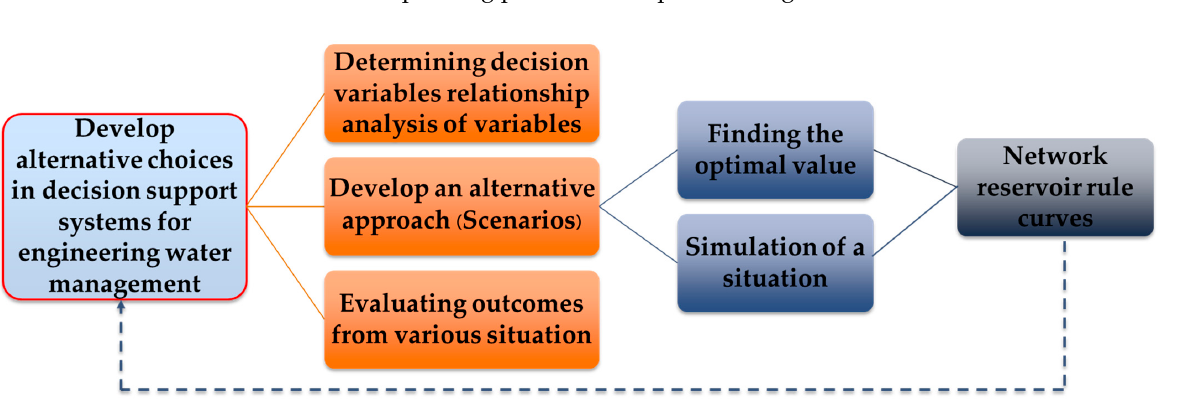
Figure 3. Historical inflow and average downstream water requirements of the Bhumibol and Sirikit reservoirs. 2.2. Establishing a Decision Support System The data used in this research study were the actual data collected from various scholarly papers, and they were formed as a database. The gathered data were also used